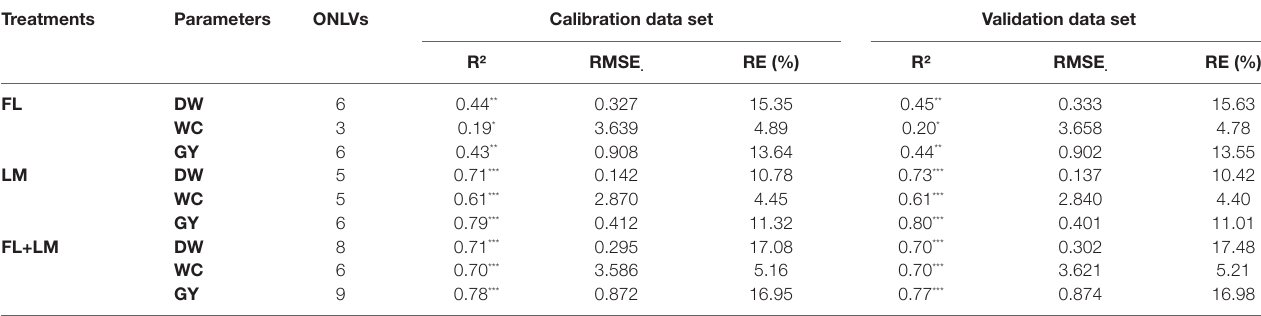
TABLe 3 | Calibration and validation statistics of partial least square regression (PLSR) models based on entire full wavelengths (350–2500 nm) for estimating shoot dry weight per square meter (DW), water content of aboveground biomass (WC), and grain yield per hectare (GY) under full irrigation (FL), limited irrigation (LM) (n = 192), and the combined two treatments (FL+LM) (n = 384). Twenty-five percent of data sets were applied for validation, while the remaining data sets were included in training set. Treatments Parameters OnLVs Calibration data set Validation data